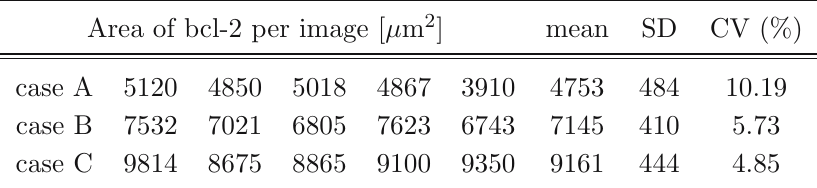
Fig. 9 Segmented bcl-2 protein from its spatial representation. Table 4 Results of repeated measurements of bcl-2 area by using colour sampling